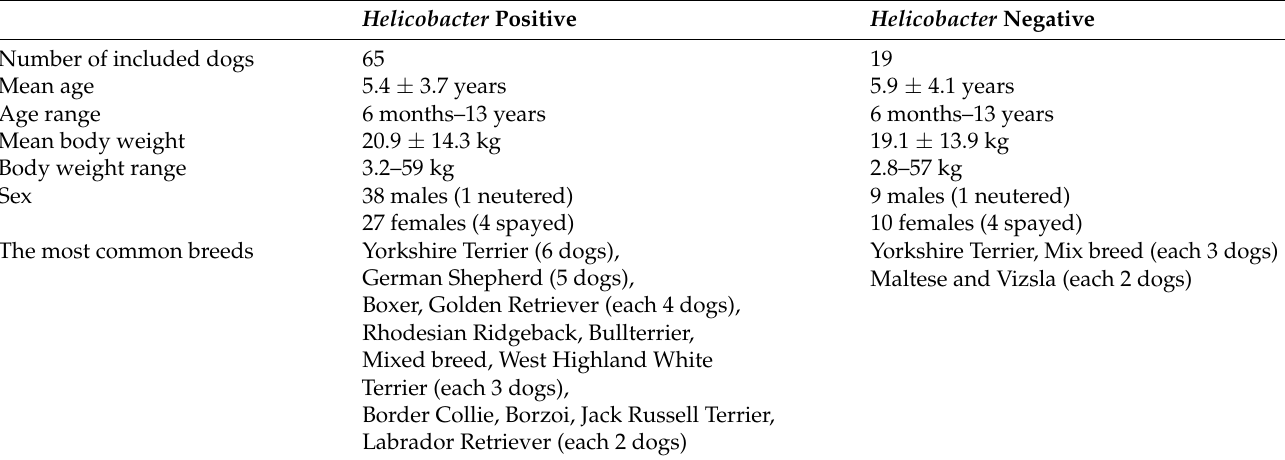
Table 2. Demographic data of 84 dogs with chronic gastrointestinal signs enrolled into the